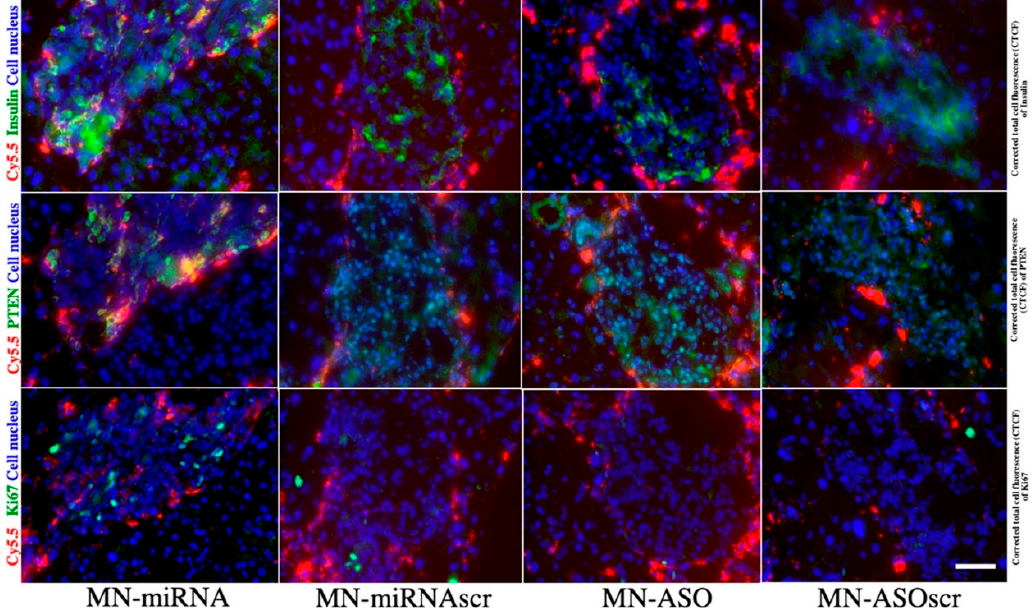
Figure 2. Fluorescence microscopy of consecutive frozen pancreatic sections from STZ-induced diabetic mice injected with MN-miRNA, MN-ASO, MN-miRNAscr, and MN-ASOscr. Animals injected with MN-miRNA showed higher insulin expression in pancreatic islets (top: green, insulin; red, Cy5.5; blue, cell nucleus) when compared to the animals injected with MN-ASO or control nanodrugs. These animals also showed downregulated PTEN expression in their islets (middle: green, PTEN; red, Cy5.5; blue, cell nucleus) when compared to the animals injected with MN-ASO or control nanodrugs. Finally, there was a notably higher cell proliferation in the islets of these animals when compared to controls (bottom green, Ki67; red, Cy5.5; blue, cell nucleus); Magnification bar = 40 μ m. All experiments were performed in triplicates, reproduced with permission from Springer Nature [124] .